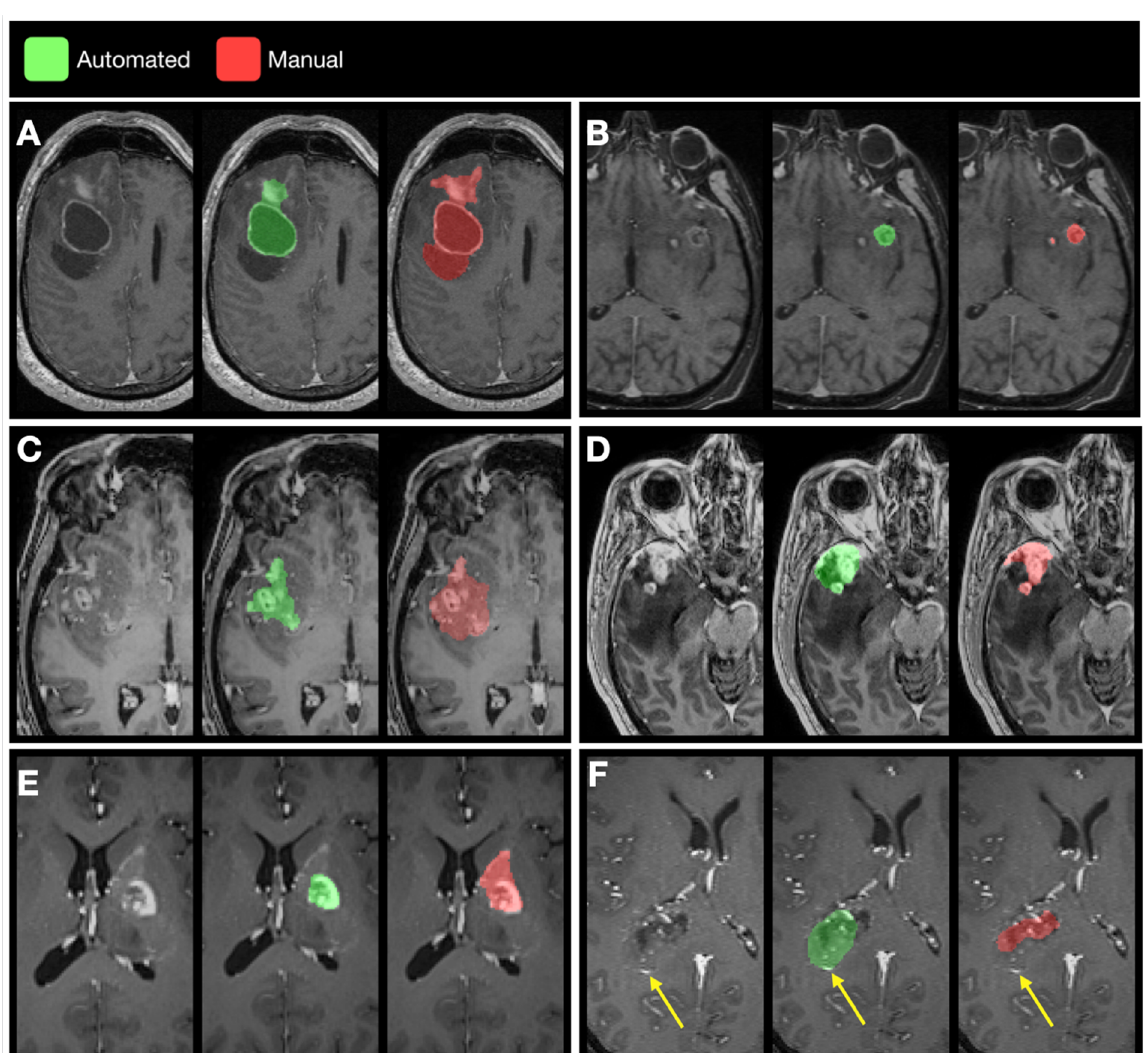
Figure 8. Examples of disagreement between manual and automated segmentation. ( A ) The automated and manual segmentation both included the tumor cyst with enhancing rim, but the automated segmentation did not include the cyst without enhancing rim nor some of the solid tumor extensions, as examples of false negative cyst detection. ( B ) The automated segmentation did not include the satellite lesion, as example of false negative enhancing tumor component. ( C ) The manual segmentation included tissue as tumor portions, whereas the automated segmentation did not, as example of either false positive inclusion of nonenhancing tissue by the manual segmentation or false negative exclusion of nonenhancing tumor exclusion by the automated segmentation. ( D ) Conversely, the manual segmentation excluded tissue from the tumor compartment, whereas the automated segmentation included this tissue, as example of either false negative exclusion of nonenhancing tissue by the manual segmentation or false positive inclusion of nonenhancing tumor exclusion by the automated segmentation. ( E ) The manual segmentation included a vascular structure, as example of a false positive vasculature structure. ( F ) Conversely, the automated segmentation included a vascular structure indicated by the yellow arrow, as another example of a false positive finding.